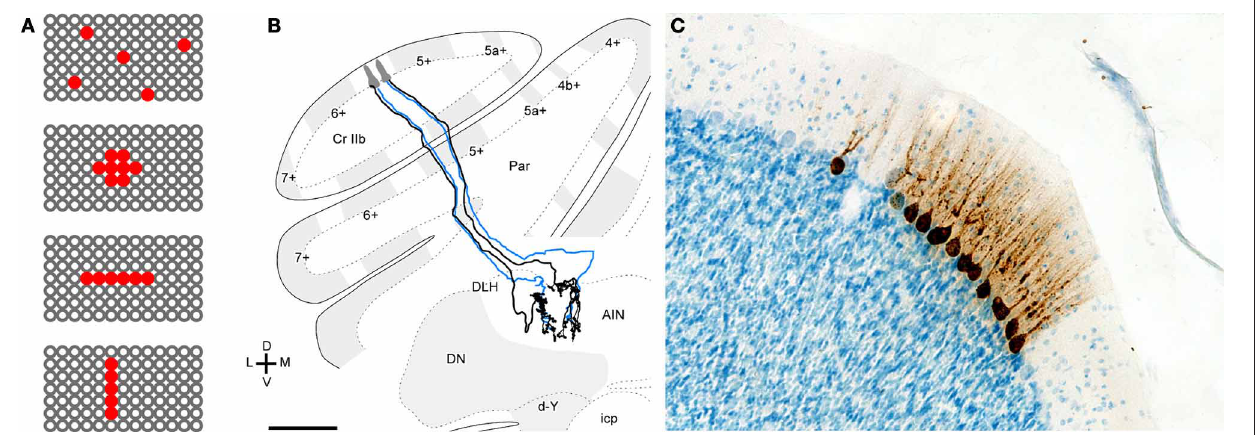
FIGURE 4 | Evidence for related functional roles of neighboring Purkinje cells. (A) Schematic illustrating a surface view of the cerebellar cortex with red indicating possible patterns of convergent Purkinje cells. Converging Purkinje cells can be (top to bottom) widespread, clustered, on-beam, or ordered parasagittally. (B) Projections of two rat Purkinje cells that were separated transversely but located in the same aldolase C compartment. Two small injections were made in medial and lateral 5- in the apex of crus IIa. Purkinje cell axons that originated from each of the injections were reconstructed. Blue axons indicate those that were partially reconstructed, except for the fine branches in the terminal arbor.